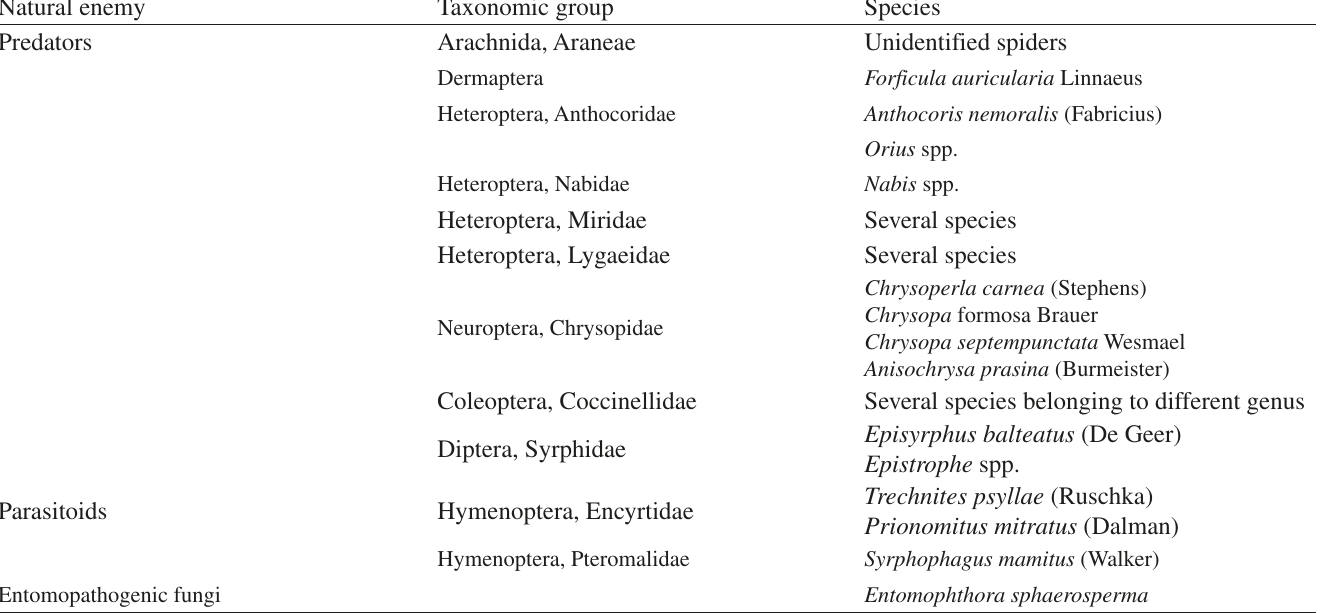
Table 1 - Natural enemies associated with pear psylla in Europe Natural